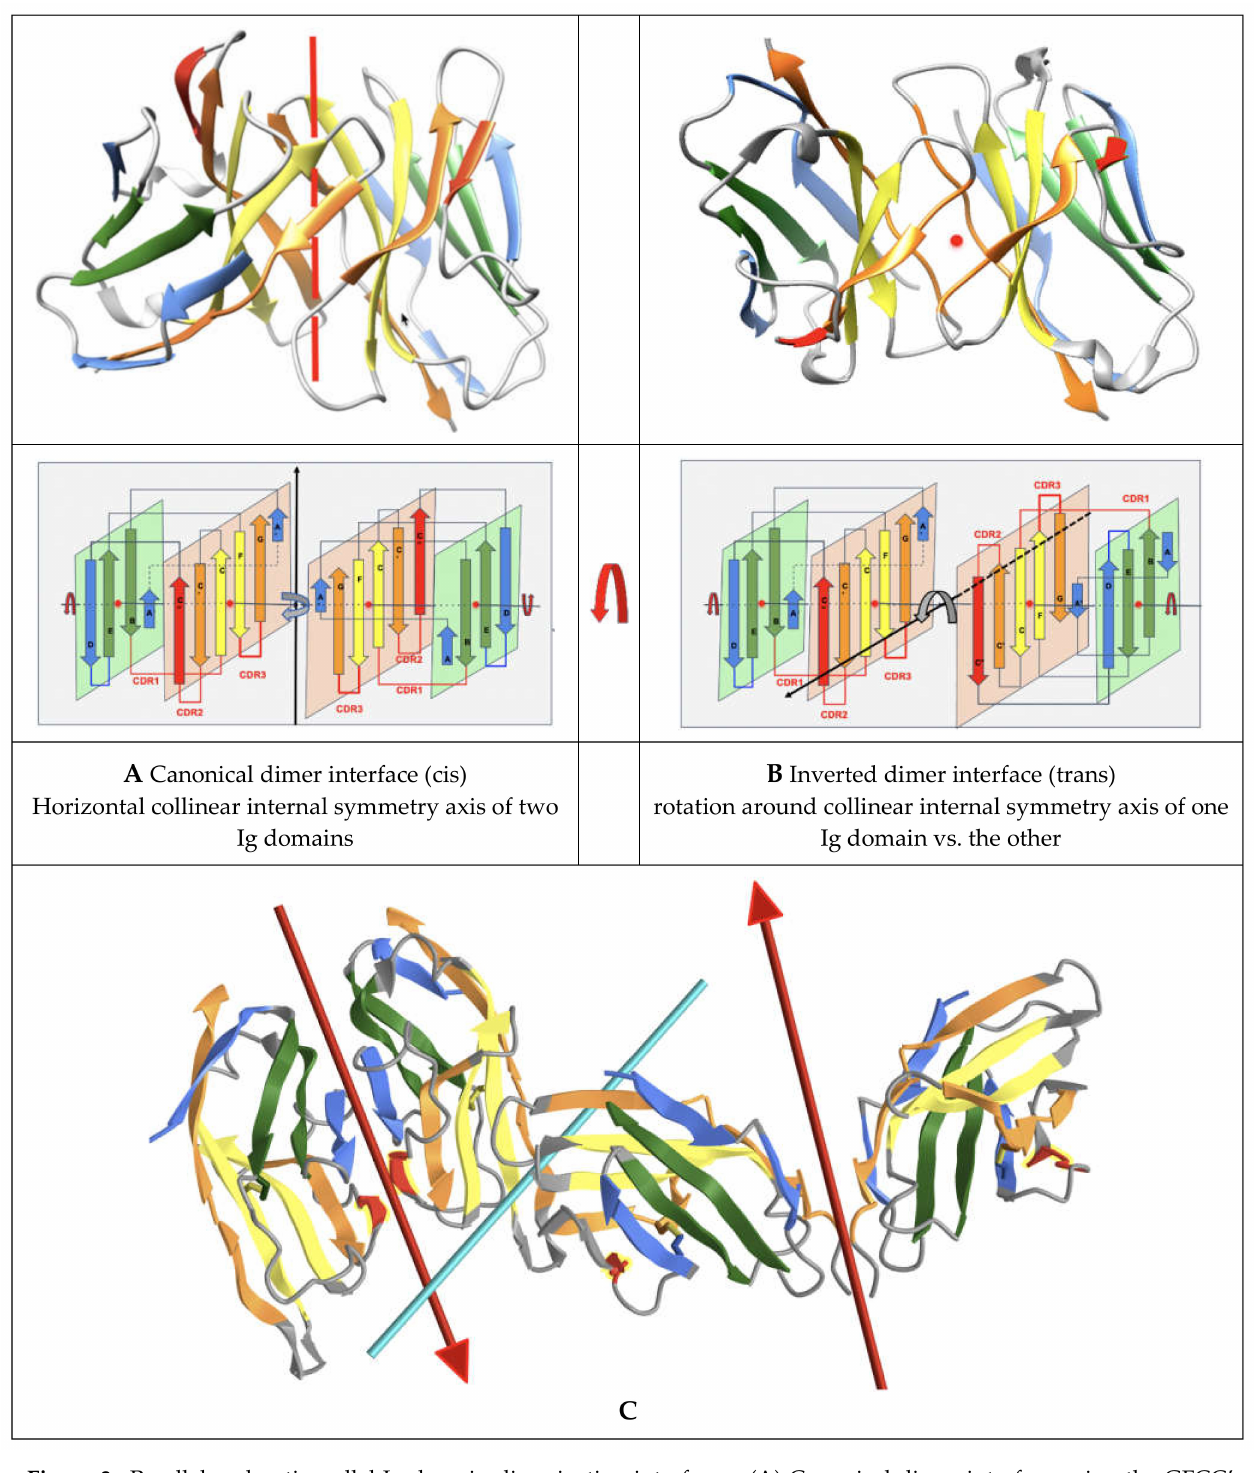
Figure 3. Parallel and antiparallel Ig domain dimerization interfaces. ( A ) Canonical dimer interface using the GFCC’ sheet: The observed quaternary axis of symmetry is vertical. This is the classical interface of antibody VH-VL domains with the CDRs on the same side. It is also found in the Bence Jones protein as a VL-VL or CD8aa as a homodimer and CD8ab as a heterodimer. The figure shows the structure of CD8aa interacting through the GFCC’ sheet in parallel. Its topology/sequence map can be seen in Figure 1 parallel homodimer (PDBid: 1CD8) (https://structure.ncbi.nlm.nih.gov/ icn3d/share.html?JcP3sd1gGfqXEBEM8, accessed on 27 August 2021) ( B ) Inverted dimer interface using the GFCC’ sheet: The observed quaternary axis of symmetry is horizontal coming out of the page plane. It corresponds to a rotation around the collinear internal symmetry axis (horizontal left to right) of one Ig domain vs. the other. In this case, CDRs are on opposite